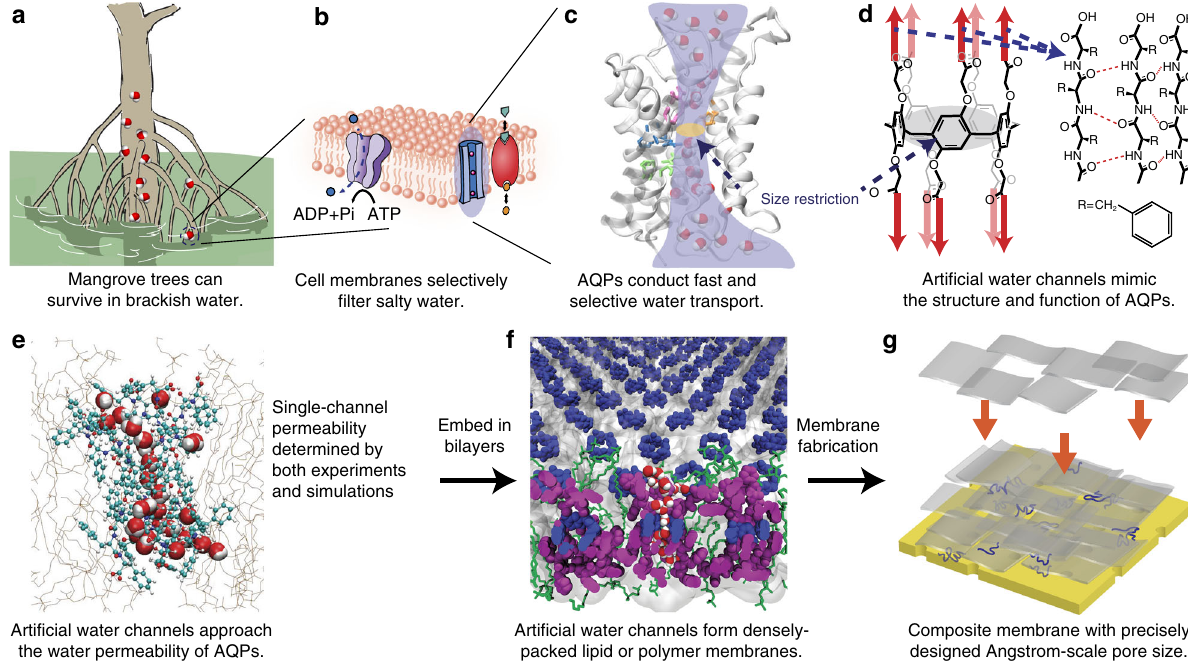
Fig. 1 Biological inspiration and molecular design of highly selective and permeable water channels, their self-assembly, and translation to macroscale membranes. a Biological cell membranes (e.g., mangrove root cell membranes) are capable of ef fi ciently and selectively transporting water. b , c This transport across membranes is mediated by transmembrane proteins including water channel proteins such as aquaporins (AQPs). d , e Arti fi cial water channels, which have a similar hydrophobic outer surface and constrict to Angstrom-scale apertures at their narrowest points like AQPs, maintain high permeability and selectivity. f , g They also provide a route toward large-scale applications owing to their relatively simple synthesis and chemical and mechanical stability. With carefully designed self-assembly and membrane fabrication procedures, densely packed arti fi cial water channel-based membranes provide molecular separation at the designed pore size while maintaining high